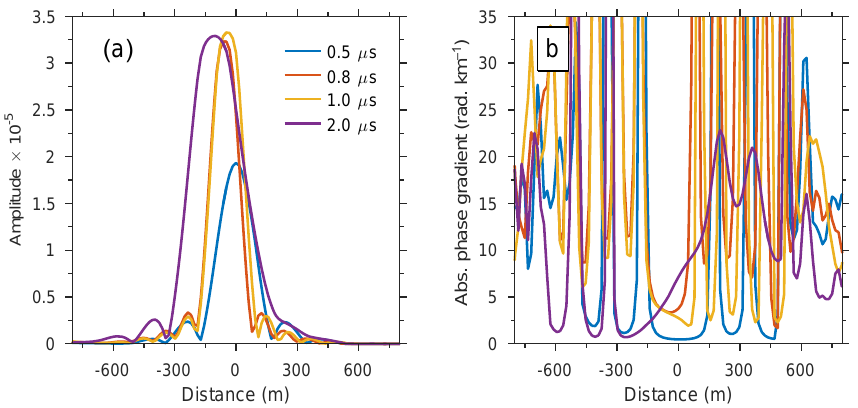
Figure 7. Impact of a nearby mast on weather radar I/Q data using four different pulse lengths. The data were recorded by Vara on 11 October 2016. Panel (a) shows the average normalised amplitudes, and panel (b) shows the corresponding average absolute phase